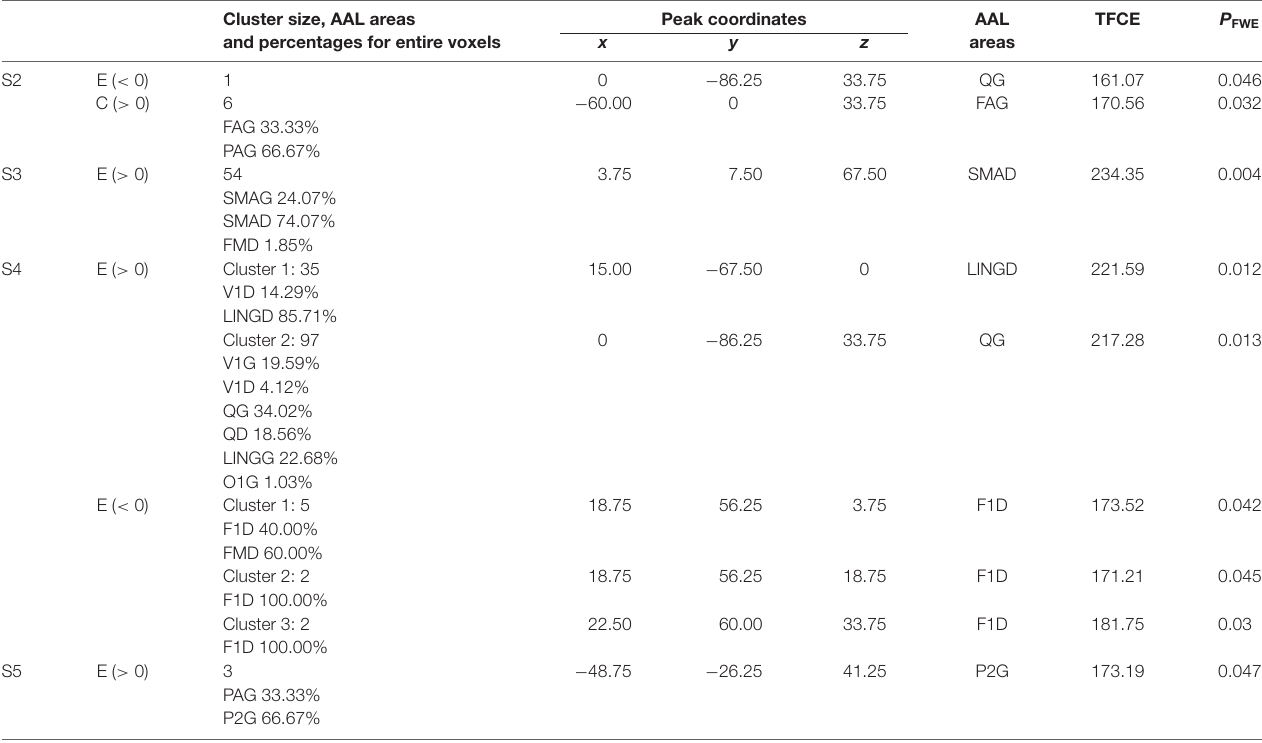
TABLE 2 | Brain areas in which fractional amplitude of low-frequency fluctuation (fALFF) at each frequency band significantly correlated with NEO-FFI scores. Cluster size, AAL areas Peak coordinates AAL